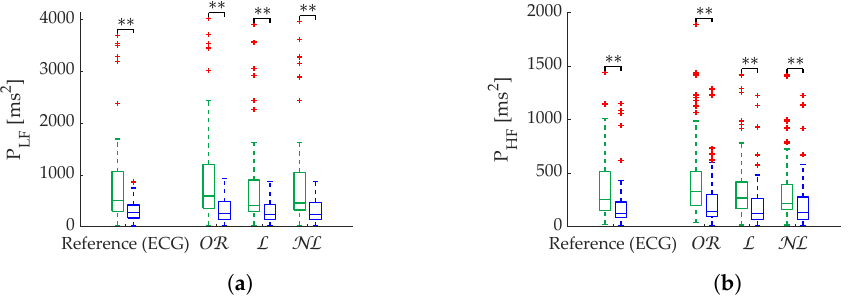
Figure 9. Relax (green)/Stress (blue) discrimination of frequency-domain metrics computed via Lomb’s method from Apple Watch dataset. ( a ) P LF . ( b ) P HF . **: Significant differences ( p < 0.001) between relax and stress groups.